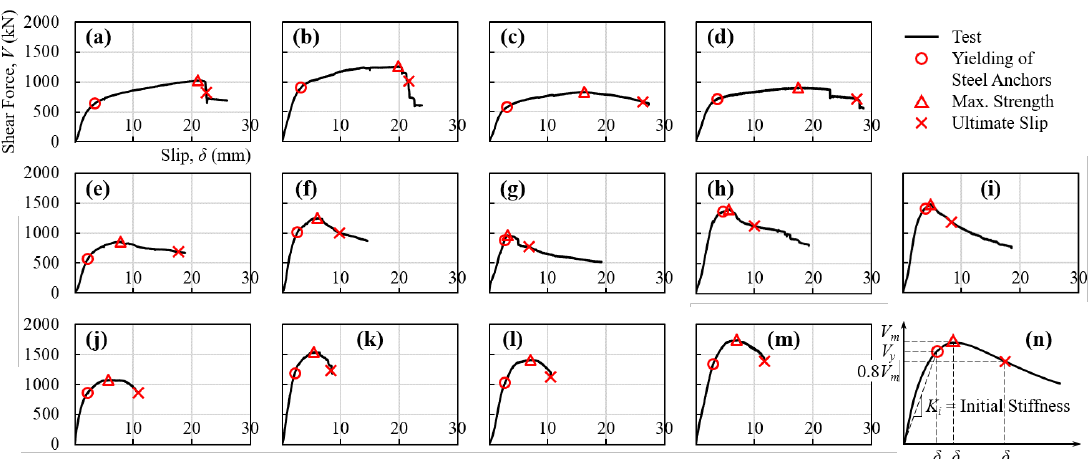
Figure 5. Shear Force—Slip Relationship: ( a ) H-S; ( b ) UI-S; ( c ) UO75-S; ( d ) UO100-S; ( e ) H-Z130; ( f ) H-Z230; ( g ) UI-Z130; ( h ) UO75-Z230; ( i ) UO100-Z230; ( j ) H-C130; ( k ) H-C230; ( l ) UI-C130; ( m ) UO100-C230; ( n ) Definitions of Performance Points.